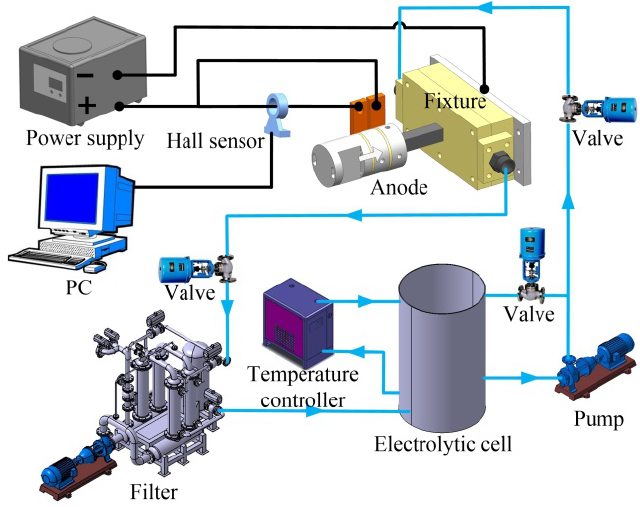
Figure 13. Experimental system.